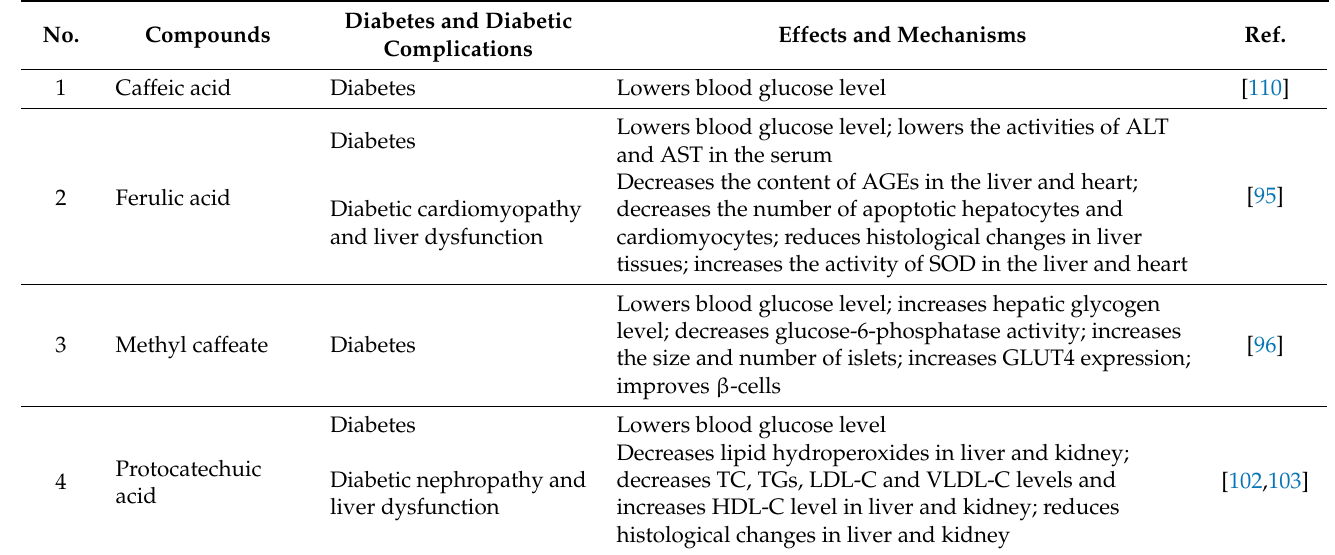
Table 2. The effects and mechanisms of some phenolic acids in O. stamineus in the treatment of diabetes and diabetic